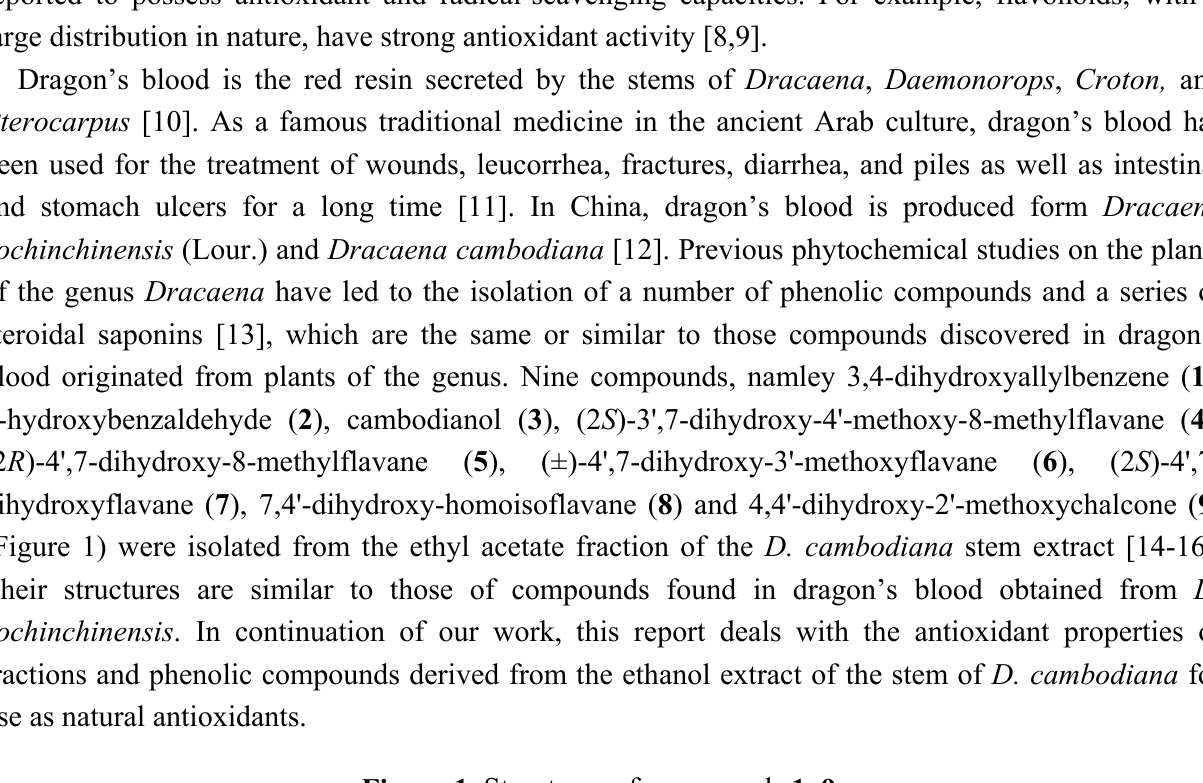
Figure 1. Structures of compounds 1 – 9